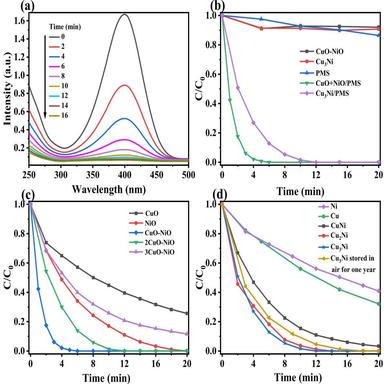
(a) UV–vis spectra of oxidation reaction of PNP at different reaction time in CuO-NiO/NC + PMS system, = 1.8 mM. (b) Degradation efficiencies of PNP in different reaction systems. (c) Comparison of the catalytic performance of products obtained by calcination of Cu and Ni in different proportions in air. (d) Comparison of the catalytic performance of products obtained by calcination of Cu and Ni in different proportions in N2. Experimental conditions: = 0.05 g/L, = 2.6 mM, = 12.5 mg/L, initial pH = 9, t